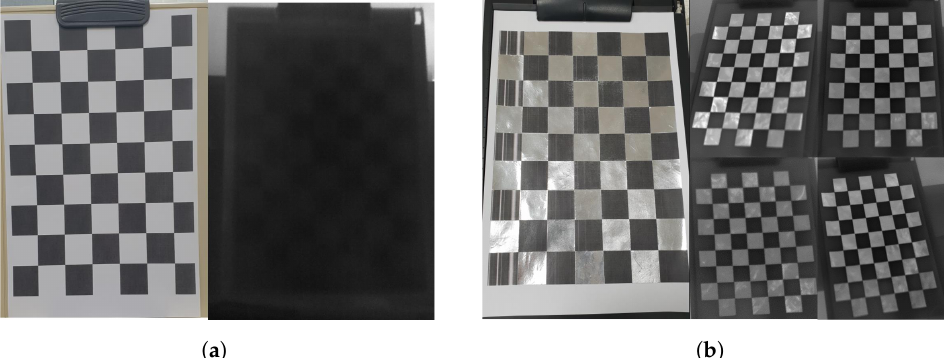
Figure 8. The calibration pattern for a thermal signal. ( a ) An ordinary checkerboard pattern (captured in visible-band and infrared band), ( b ) The checkerboard pattern improved by attaching aluminum material (captured in visible-band and infrared band).